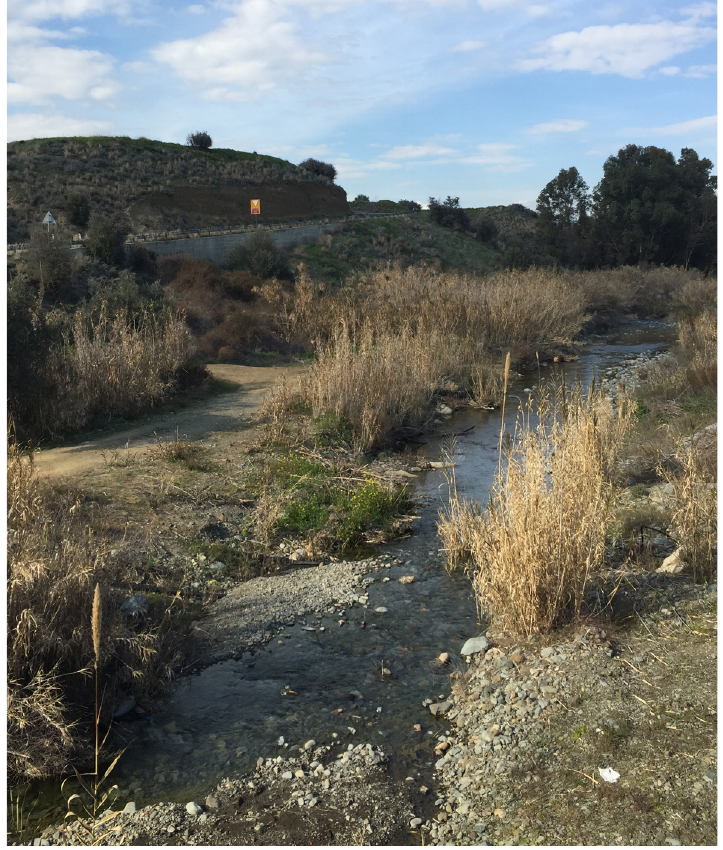
Figure 2. Water flowing in the Koutis river, tributary of the Aloupos, near Arediou. Photo: L.